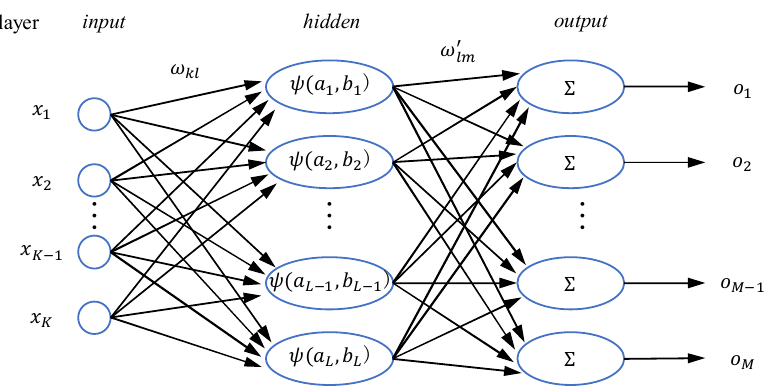
Figure 1. Structure of a three-layer WNN.